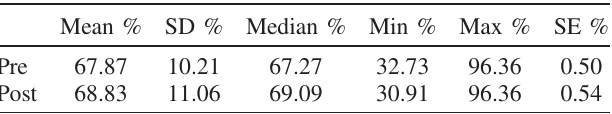
TABLE XIII. Descriptive statistics of scored pre- and postres- ponses to proposed 15-item